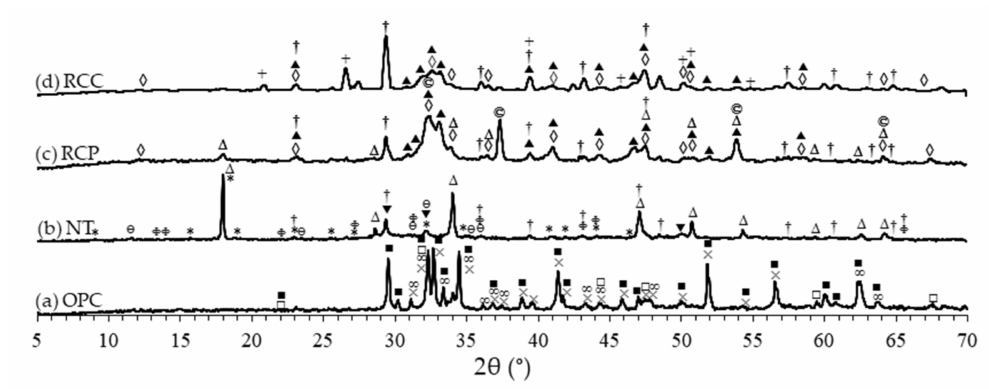
Figure 1. X-ray diffraction analysis of ( a ) OPC, ( b ) NT, ( c ) RCP and ( d ) RCC. Legend: ∆ —CH; †—CaCO 3 ; *—ettringite; ∞ —gypsum; ©—CaO; (cid:4) —C 3 S; (cid:72) —C-S-H; × — β -C 2 S; (cid:78) — α ’ H -C 2 S; (cid:3) — calcium aluminum iron oxide; (cid:51) —C 4 AF; Φ —alumohydrocalcite; θ —calcium aluminum oxide car- bonate hydrate; +—quartz.